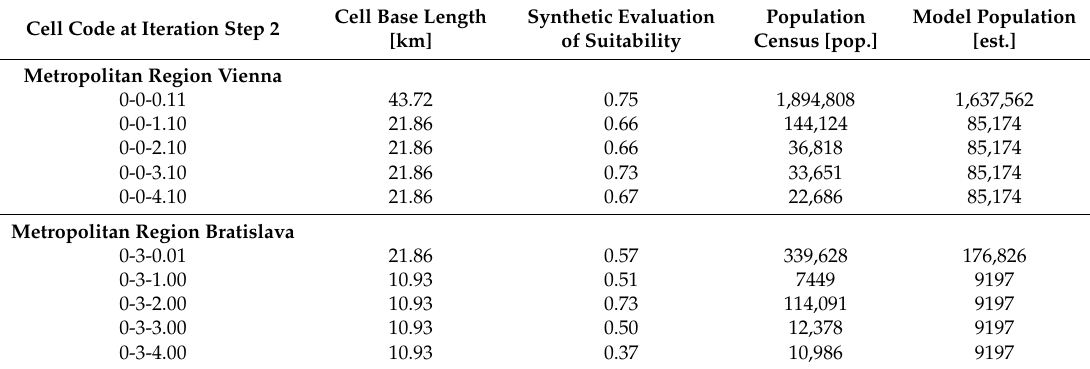
Table 3. Evaluation of each cell at iteration step 2 (coding for each cell can be found in Figure 5). Cell Base Synthetic Evaluation Cell Code at Iteration Step 2 Cell Code at Iteration Step 2